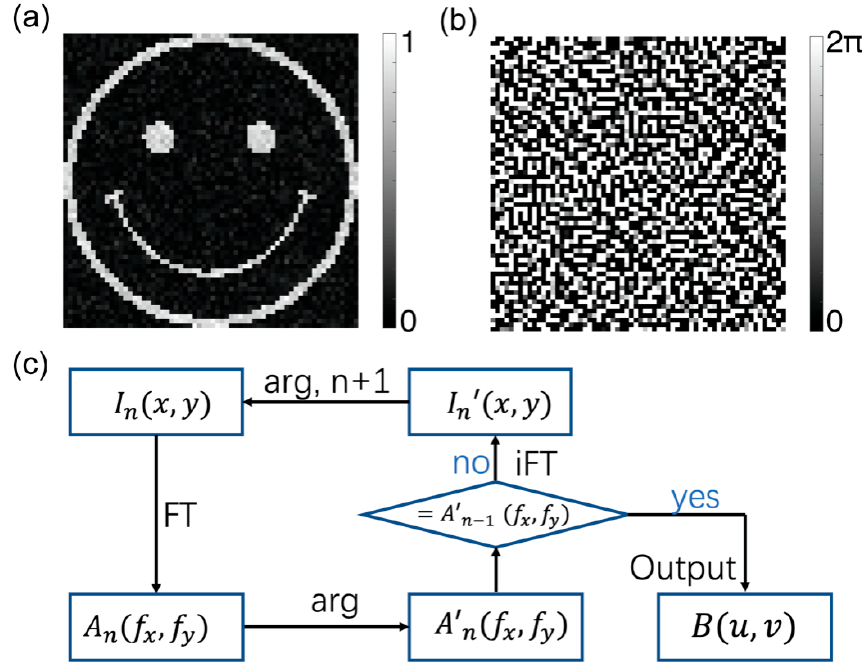
Figure 2. ( a ) Gray intensity distributions of an object 𝐼(𝑥, 𝑦) to be displayed. ( b ) Calculated phase profile 𝐵(𝑢, 𝑣) of the phase-only hologram of the object in (a). ( c ) Block diagram of the iterative Fourier transform algorithm used for calculating (b) from (a).